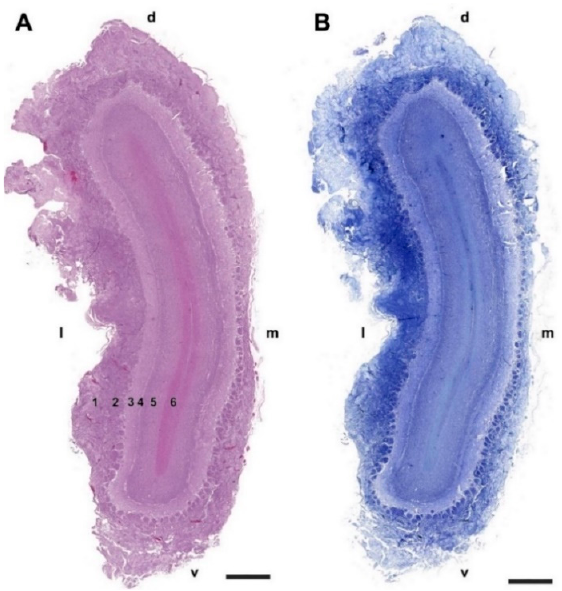
Figure 2. Transverse section of the olfactory bulb of the dog stained by hematoxylin–eosin ( A ) and Nissl staining ( B ). From superficial to deep the following layers are identified: (1) Olfactory nerve layer (NL); (2) Glomerular layer (GlL); (3) External plexiform layer (EPL); (4) Mitral cell layer (MCL); (5) Granular layer (GrL); (6) White matter. d, dorsal; l, lateral; m, medial; v, ventral. Scale bars: 2 mm.